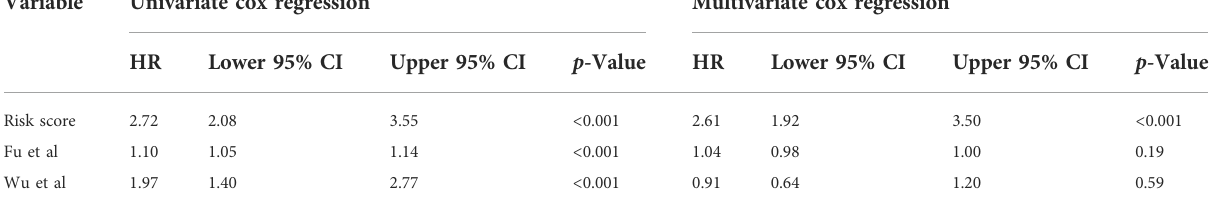
TABLE 4 Comparisons between the risks core and other prognostic models using univariate and multivariate Cox regression analyses. Variable